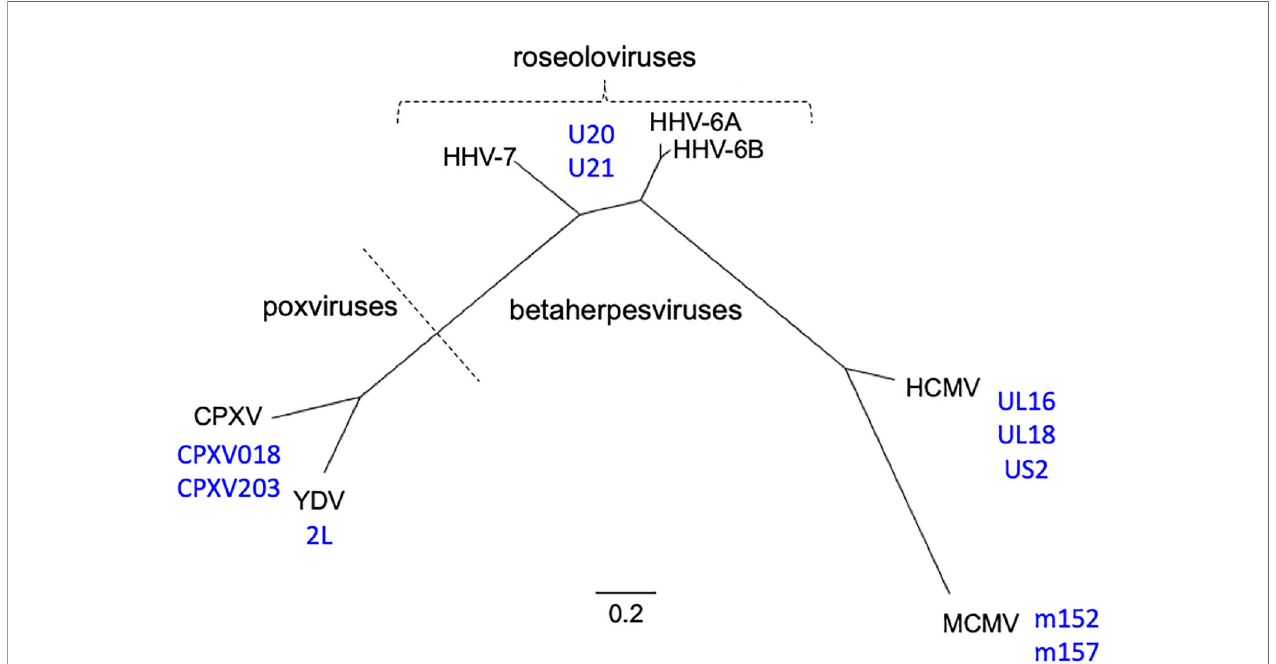
FIGURE 1 | Phylogenetic relationships of viruses and viral immunoevasins discussed in this work. The complete genomic DNA sequences from HHV-6A (strain U1102), HHV-6B (strain Z29), HHV-7 (strain JI), HCMV (strain HAN-SCT17), and MCMV (strain N1) and poxviruses Cowpox (strain Brighton Red) and Yaba-like Disease Virus (strain Amano) were retrieved from the VIPR database ( Table 1 ) and aligned using the MEGA11 software package. MEGA was then used to generate a maximum likelihood phylogeny reconstruction (1). Scale bar represents the probability of a nucleotide substitution at a given site, calculated for select betaherpesviruses. Viral MHC- like proteins that contribute to evasion of host T cell and NK cell responses and are discussed in this work are indicated next to the virus labels.